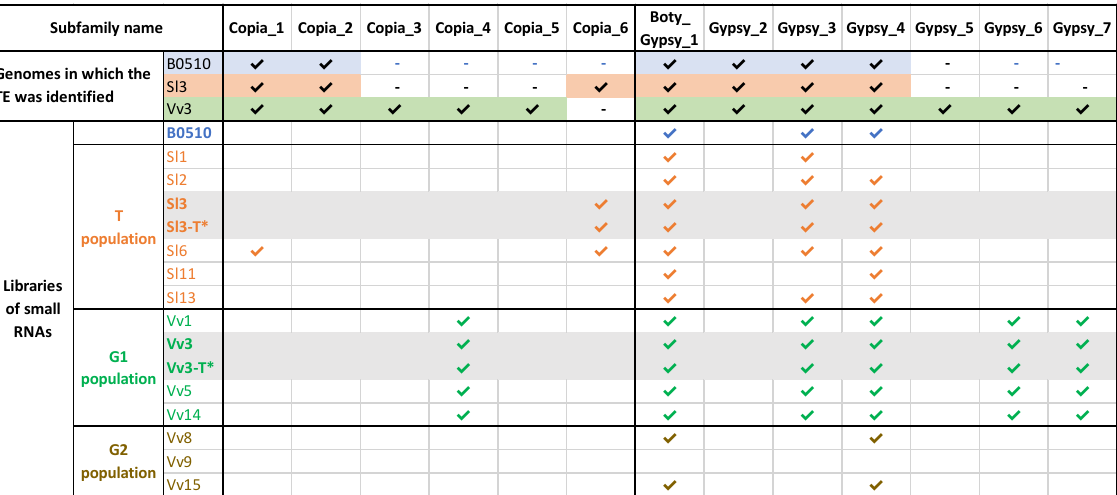
Table 2: Small RNAs produced by the Transposable Elements (TEs) identified in the B. cinerea strains B05.10, Sl3 and Vv3. Small RNA libraries were made from strains cultivated on grape juice medium except two that were done from strains cultivated on tomato juice medium (indicated by -T*). Reads from the 16 libraries were mapped on the TEs to identify the small RNA-producing retrotransposons. For small RNAs, indicates that at least 300 Reads Per Million (RPMs) from the library are mapping on the ✔ corresponding TE. Genomes in which the TEs were identified are reminded at the top of the table ( presence. -, absence). For more details, see Sup. Table